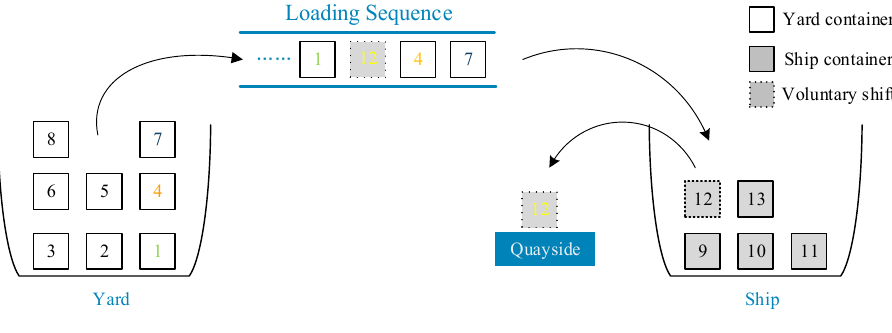
Figure 6. Flow chart of the CSPP.